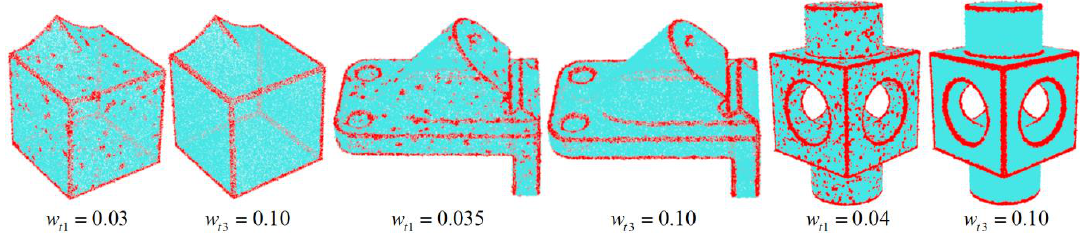
Figure 3. Feature detection results by common method [11] and our method under large-scale noise. Left: smooth-feature model with 0.25% Gaussian noise. Middle: anchor model with 0.30% Gaussian noise. Right: block model with 0.30% Gaussian noise.